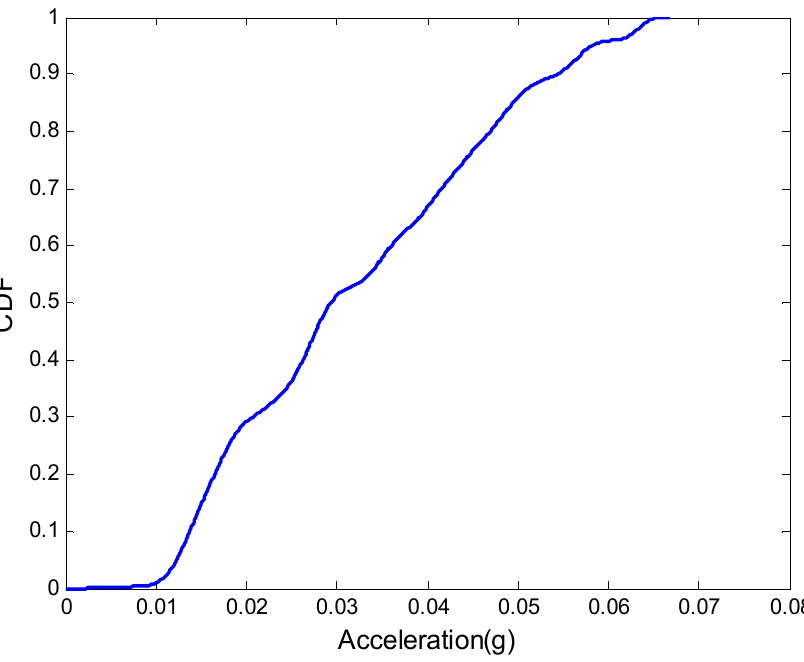
Figure 7. Vibration comfort reliability of the superstructure represented by acceleration.